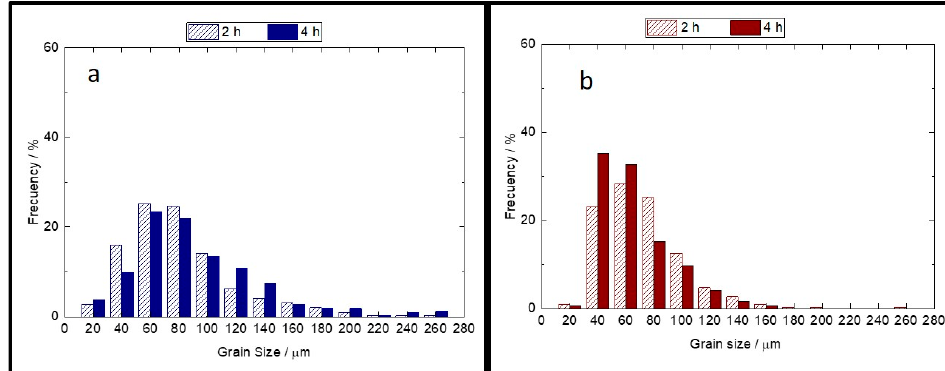
Figure 6. Particle size distribution histograms determined from SEM measurements of AA7075- MWCNT composite particles after 2 h and 4 h of HEBM: ( a ) 0.5 wt.% MWCNTs; ( b ) 1 wt.% MWCNTs.